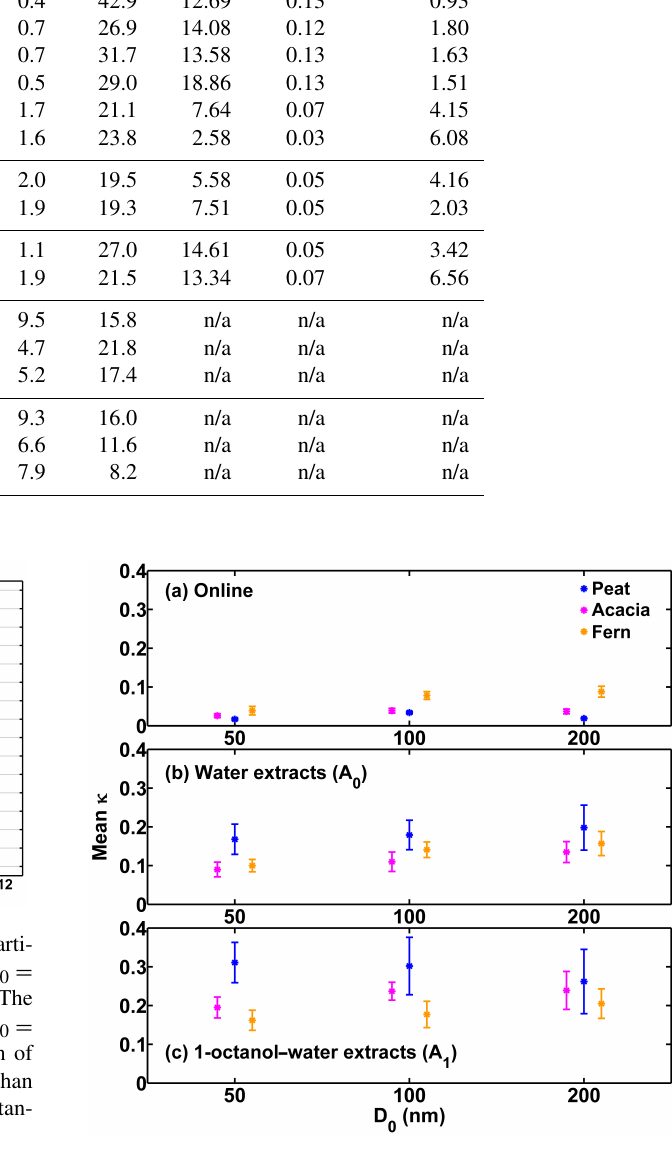
area, Riau-4, 100 nm) (Fig. 4 and Table 2). The κ value for peat burning particles ( A 0 ) is significantly higher than